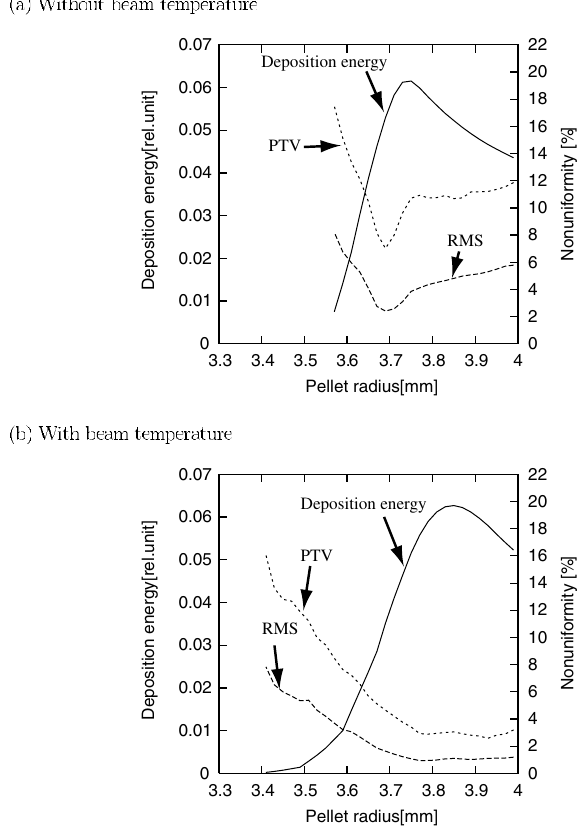
FIG. 5. The deposition energy of beam particles in the rela- tive unit and nonuniformities at each surface in the cases (a) without the beam temperature effect and (b) with the tempera- ture effect for the Al layer target for the chamber radius of 5 m, 120-beam system, and the semi-Gaussian